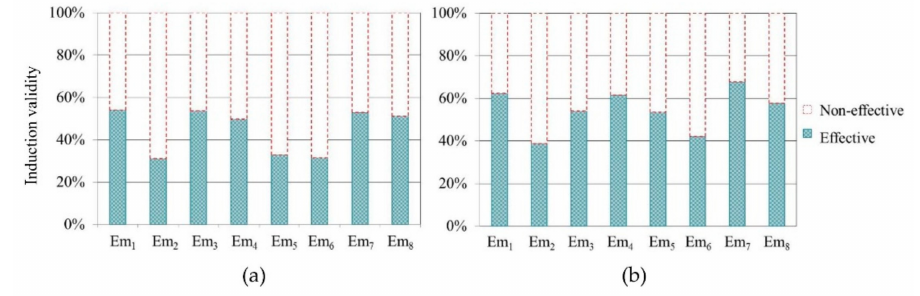
Figure 12. Emotion measurement results. ( a ) Actual driving experiments; ( b ) Virtual driving